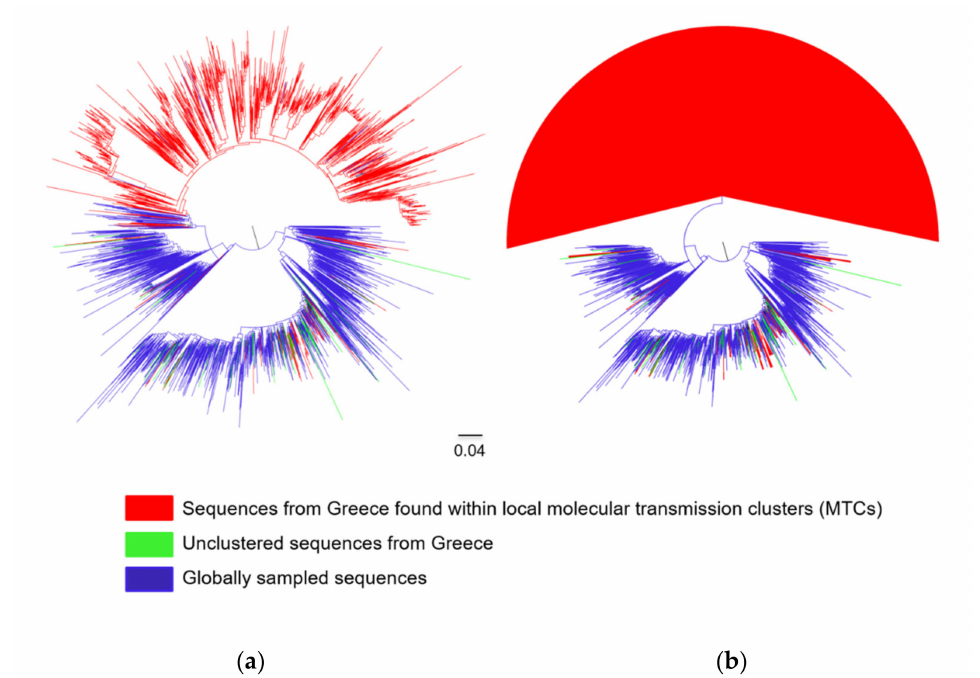
Figure 1. Unrooted phylogenetic trees estimated by RAxML v8.2.10 of HIV-1 subtype A1 sequences from Greece and a global reference dataset. ( a ) Sequences from Greece are marked in light green (unclustered sequences) and red (sequences found within local molecular transmission clusters-MTCs) in contrast with sequences from other countries marked in blue. ( b ) The MTCs are indicated as triangles.